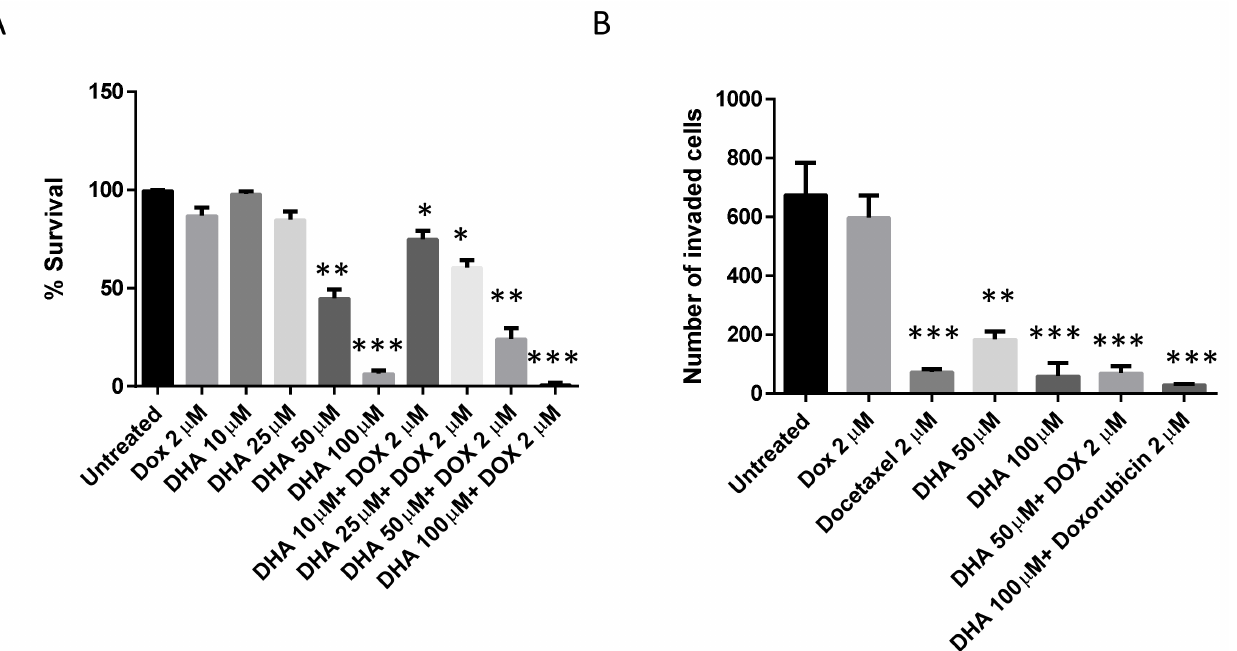
Figure 1. The impact of DHA on the proliferation, and invasion of doxorubicin-resistant MCF-7 breast cancer cells (MCF-7/Dox). ( A ) For the cell proliferation experiment, the MCF-7/Dox cells were treated with various concentrations of DHA, doxorubicin (2 µ M) alone or in combination for 48 h, and stained using a crystal violet staining solution and measured the absorbance to determine the percent survival of cells. ( B ) For the invasion experiment, MCF-7/Dox cells in serum free medium were placed in the upper chamber of a 24-well BioCoat Matrigel invasion chamber and the lower chamber was filled with varying concentrations of DHA with or without doxorubicin (2 µ M) in serum containing medium or with 2 µ M of docetaxel alone as a positive control. After 48 h of incubation, the cells that traversed the membrane pores to the lower side were fixed with 10% formalin, stained with 0.1% crystal violet blue, and counted manually. The values shown represent the average ± standard error of the mean, obtained from three separate experiments. A p -value of <0.05 is considered significant by a Newman–Keuls one-way ANOVA with multiple comparisons test. * p < 0.05, ** p < 0.01, *** p < 0.001 compared to untreated